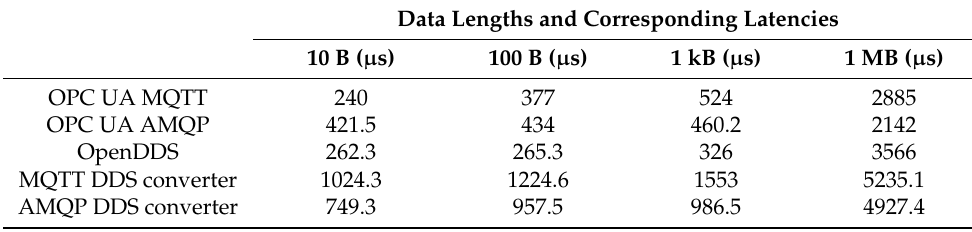
Table 9. Performance analysis results/latencies for various data